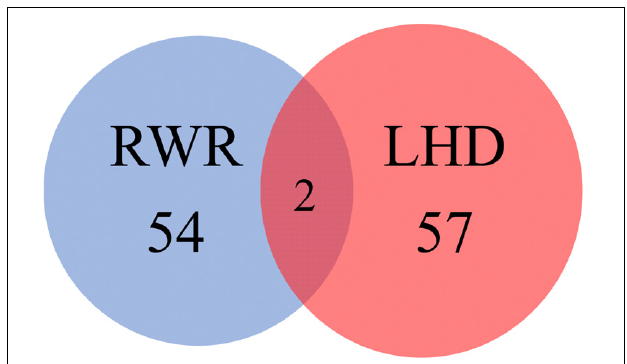
FIGURE 3 | Venn diagram illustrating two gene sets, consisting of novel genes in a previous study and inferred genes reported in this study. The blue circle represents the gene set consisting of novel genes in a previous study, which adopted RWR algorithm to search novel genes; while the red circle represents the gene set containing the inferred genes reported in this study, which were identified by LHD algorithm.